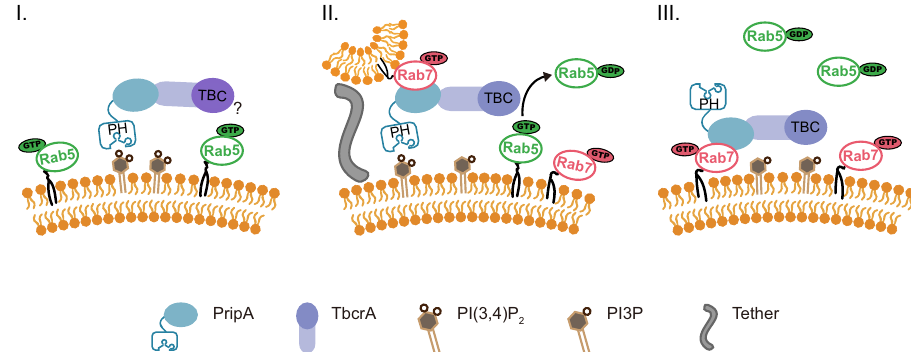
Fig. 9 Schematic of Rab5-to-Rab7 conversion modulated by the PripA-TbcrA complex. The PripA-TbcrA complex acts as the central component of a Rab GAP cascade regulating macropinosome maturation in Dictyostelium . The initial stage (I) of macropinosome maturation occurs shortly after ruf fl e closure, in which PI(3,4)P 2 on newly formed Rab5-enriched macropinosomes recruits PripA and TbcrA. The PripA-TbcrA complex may be required to sharpen Rab5 activation at this early stage, or alternatively, it may not yet become fully active (indicted by the question mark). In the second stage (II), tethering and fusion of Rab7-positive late macropinosomes with early macropinosomes mediate additional PripA-TbcrA recruitment. The ability of PripA to interact with both PI(3,4)P 2 and Rab7 may link the two membrane compartments, and other tethering factors yet to be identi fi ed likely reinforce such association. At the same time, interactions among active Rab7, PripA, and TbcrA may stimulate the GAP activity of TbcrA to promote Rab5-GTP hydrolysis. In this way, Rab5 is turned off when the PripA-TbcrA complex responds to Rab7-GTP, which ensures consecutive function of Rab5 and Rab7. In the fi nal stage (III), early macropinosomes mature into late macropinosomes marked by Rab7. The macropinosome maturation process is accompanied by the degradation of PI(3,4)P 2 to